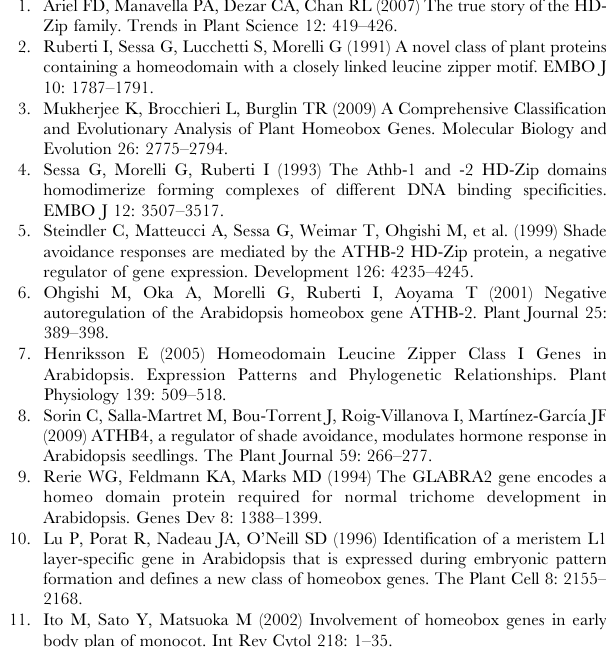
maize events. ATHB17 mRNA sequence identifies truncation of the 5 9 region of the ATHB17 coding sequence. This transcript sequence is predicted to produce a truncated protein lacking the first 113 amino acids. (D) Domain structure of ATHB17. ATHB17 coding sequence contains canonical Homeodomain and Leucine Zipper (LZ) domains of HD-Zip family. Homeodomain is required for DNA binding. LZ domain is responsible for homodimerization and hetero-dimerrization with other HD-Zip II proteins. A repression domain is present upstream to the homeodomain. ATHB17 protein expressed in transgenic maize events lacks the first 113 amino acids resulting in deletion of part of repression domain containing EAR-like motif. Figure S2 ATHB17 D 113 will function via dominant negative mechanism. ATHB17 is expressed as truncated protein in maize lacking part of the repression domain. Maize endogenous HD-Zip IIs function as transcriptional repressors. ATHB17 D 113 can interact with endogenous HD-Zip IIs and sequester endogenous proteins from binding to their targets resulting in relief of repression caused by maize HD-Zip IIs. In addition, heterodimer of ATHB17 D 113 and endogenous HD-Zip IIs or ATHB17 D 113 homodimers can compete for DNA binding resulting in altered target expression due to inability to cause active repression. Table S1 Evaluating ATHB17 D 113 binding affinities with various mutations in targets DNA measured by OctectQK; locally fitted. Table S2 Phenology of ATHB17 events and control. The number of days to 50% silking and anthesis were measured and the number of days between anthesis and silking was calculated (ASI) each year for physiological studies conducted under standard agronomic practices conditions. Differences in phenology between ATHB17 events and control were determined using a fixed effects